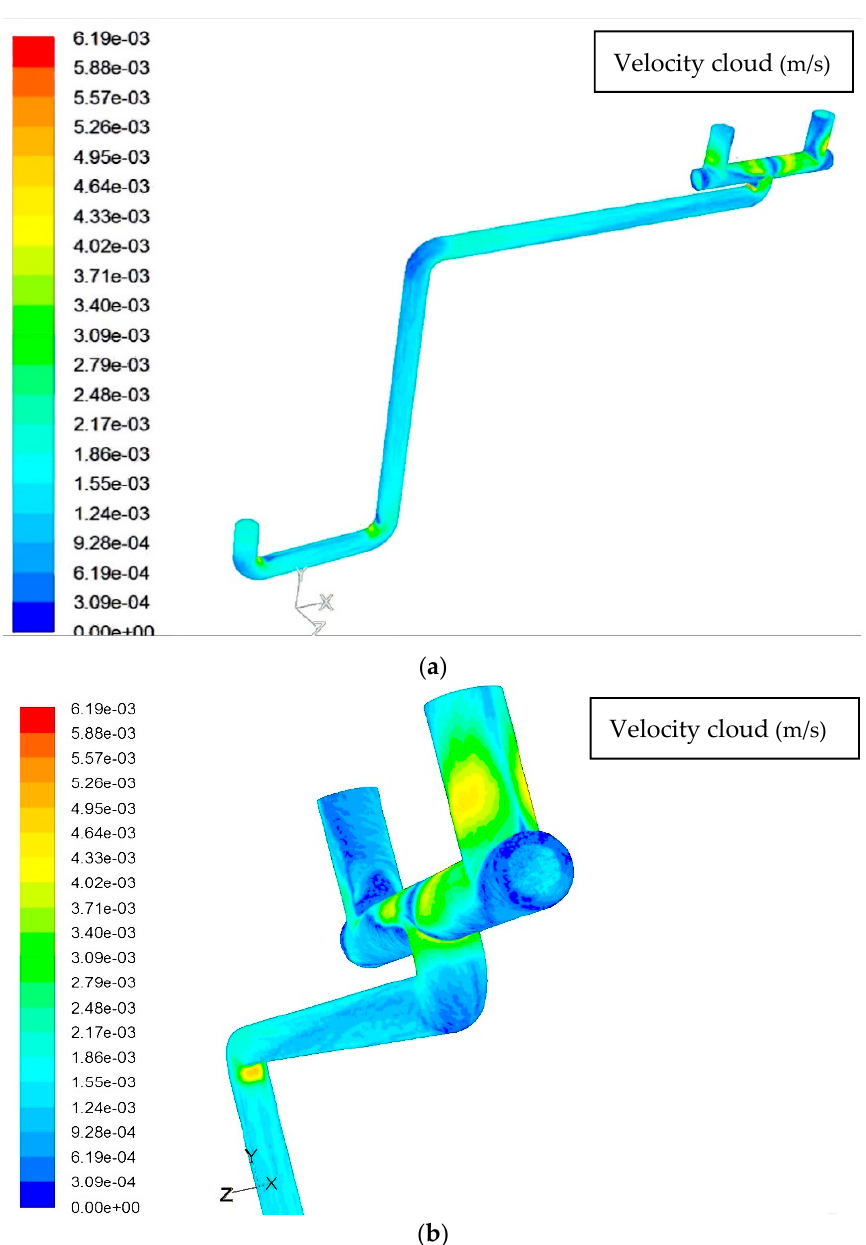
Figure 28. The erosion distribution map of pipeline 01-EA002/2, ( a ) General view of erosion division; ( b ) Partial view of erosion division.